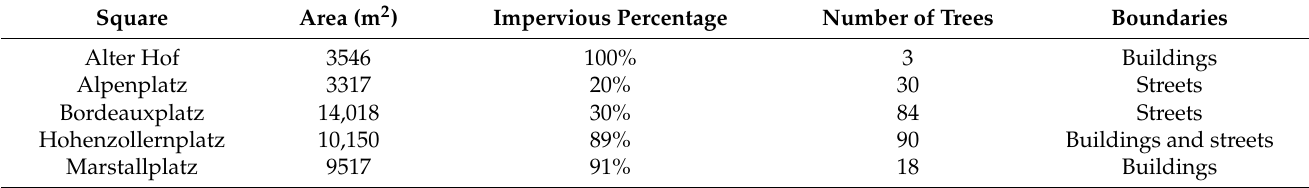
Table 1. Variables considered for square selection (Source: 100Places:M).